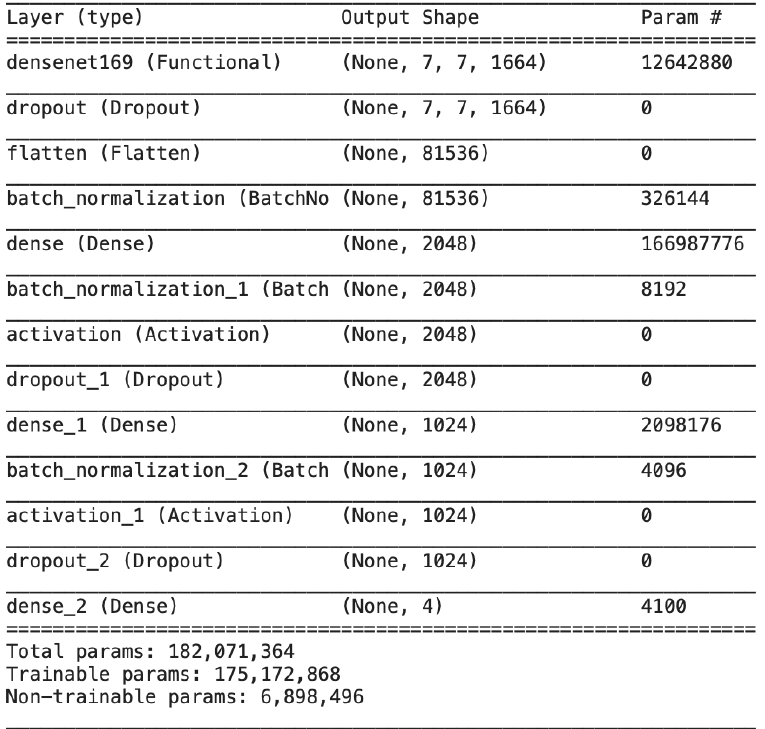
Figure 10. Output size and model parameters at each layer of the proposed DenseNet.